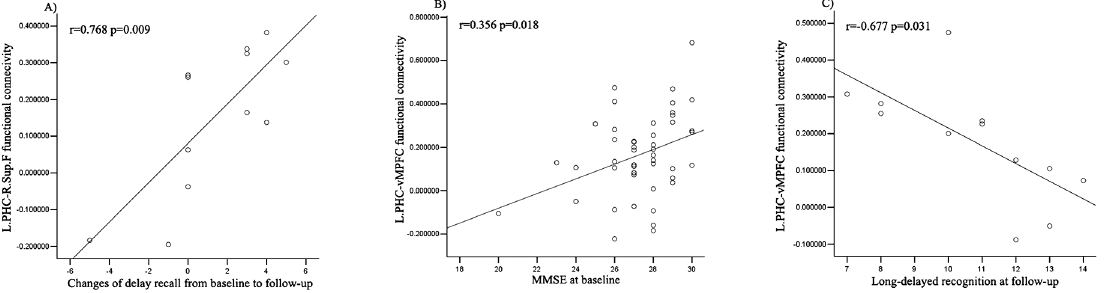
Fig 2. Changed functional connectivity was associated with cognitive performances. A. The increased LPHC-R.Sup.F functional connectivity was positively correlated with the changes of delay recall from baseline to follow-up. B. The increased LPHC-vMPFC functional connectivity had a positive correlation with MMSE at baseline, and C. a negative correlation with long-delayed recognition at